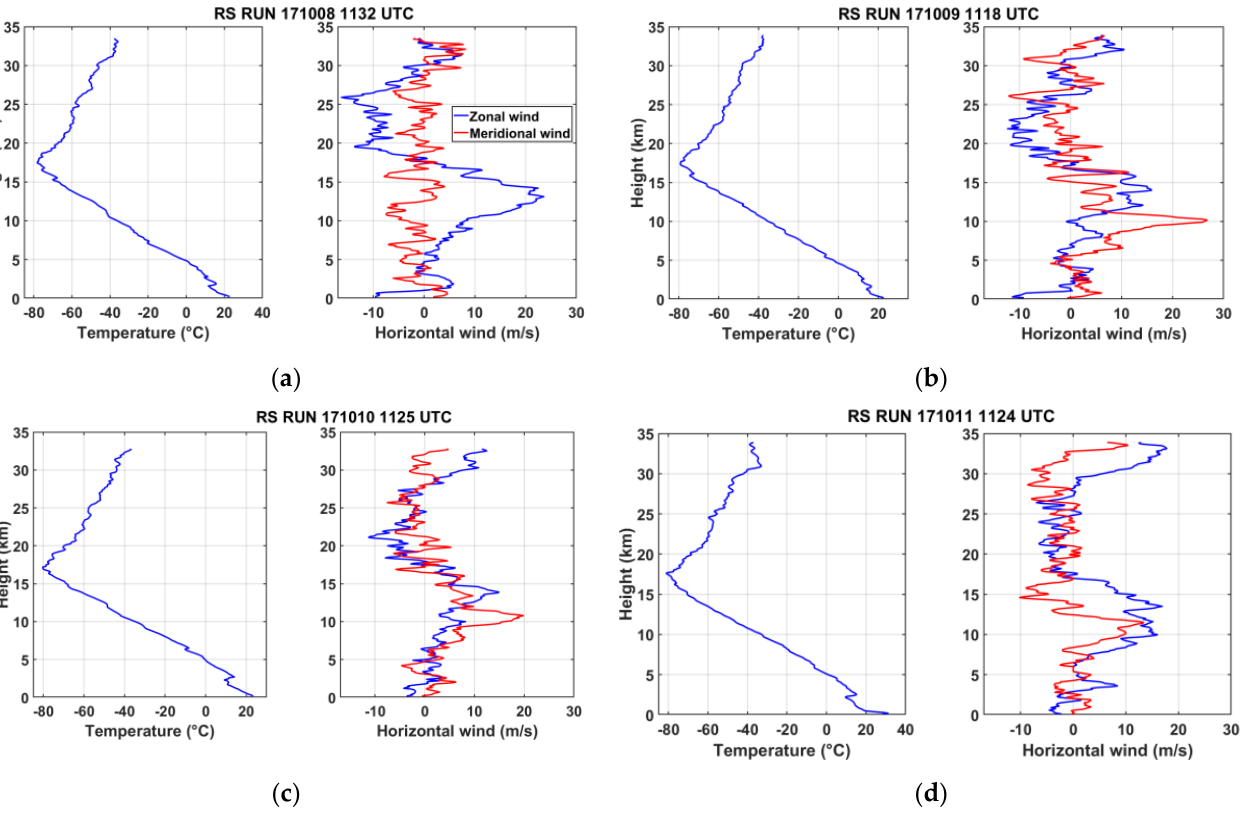
Figure 1. Vertical profiles of temperature (left panel), horizontal wind (right panel, zonal wind in blue, meridional wind in red) on ( a ) 8 October, ( b ) 9 October, ( c ) 10 October and ( d ) 11 October 2017 from radiosonde measurements at La Réunion (RS RUN).